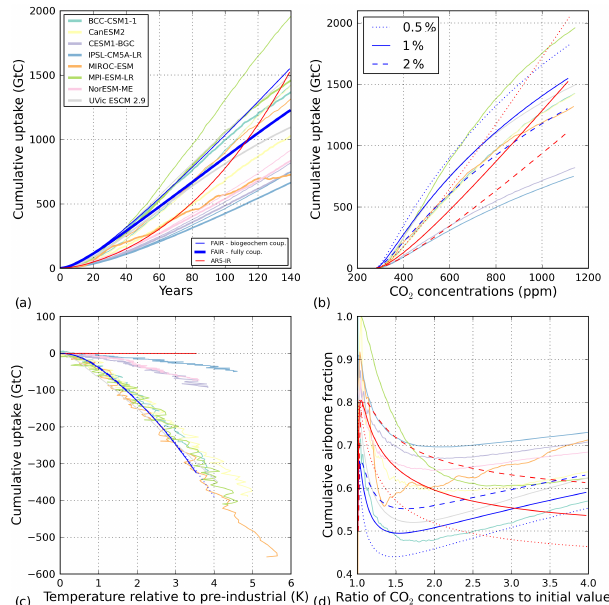
Figure 6. Response to idealised concentration increase experiments from Gregory et al. (2009) for the FAIR (blue) and AR5-IR (red) models. Light pastel colours show the ESMs from Joos et al. (2013) for the 1%year − 1 concentration increase scenario only. (a) shows the cumulative ocean and land carbon uptake over time in the “fully coupled” 1%year − 1 concentration increase scenario. (b) shows the evolution of cumulative ocean and land carbon uptake as a func- tion of atmospheric concentration in the “biogeochemically cou- pled” experiment for 1%year − 1 (solid), 2%year − 1 (dashed), and 0.5%year − 1 (dotted) experiments. (c) shows the cumulative up- take as a function of temperature in the “radiatively coupled” ex- periments. (d) shows the evolution of the cumulative airborne frac- tion as a function of the proportional concentration increase for the “fully coupled”